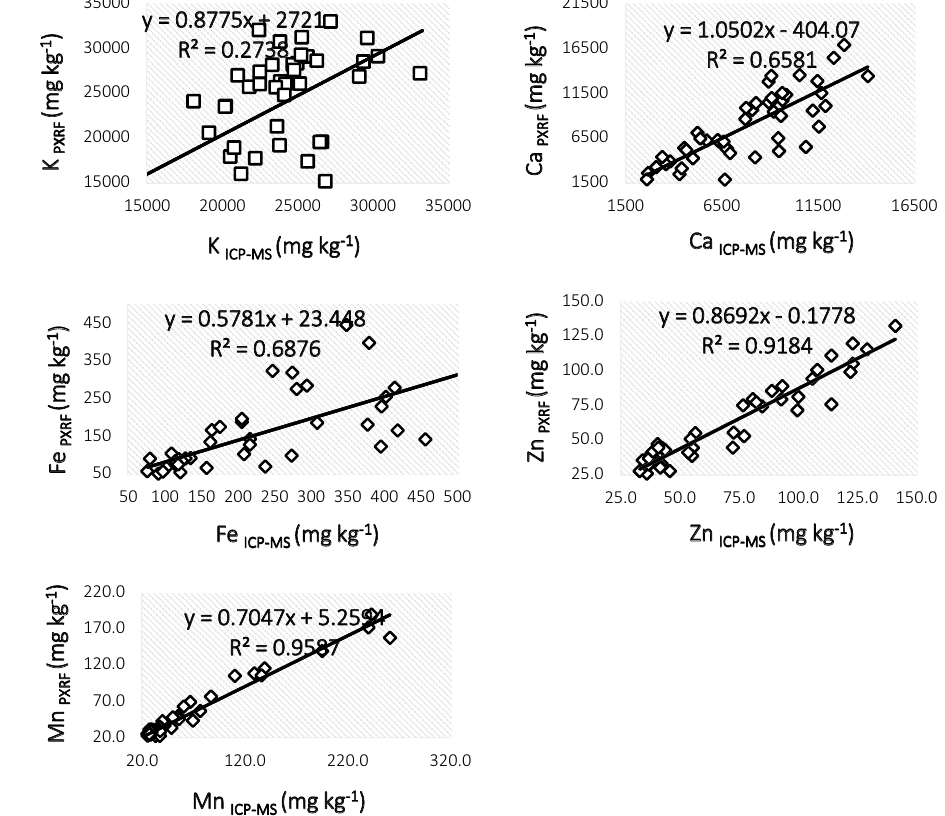
yy == 00..88777755xx ++